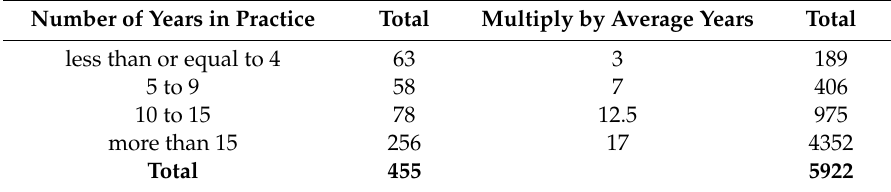
Table 3. Estimate of OIH per practice year using the number of years in practice.